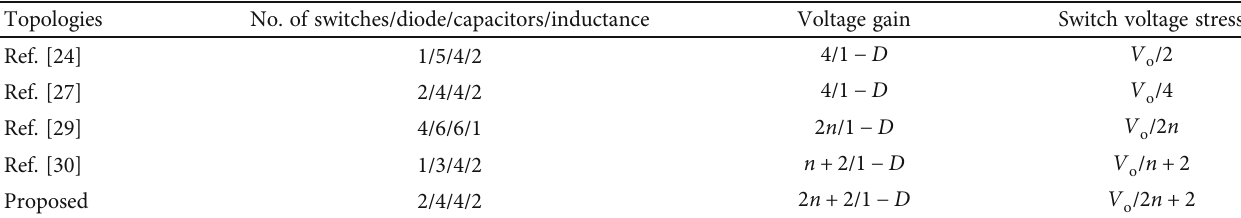
Table 1: Comparison of the proposed converter to typical